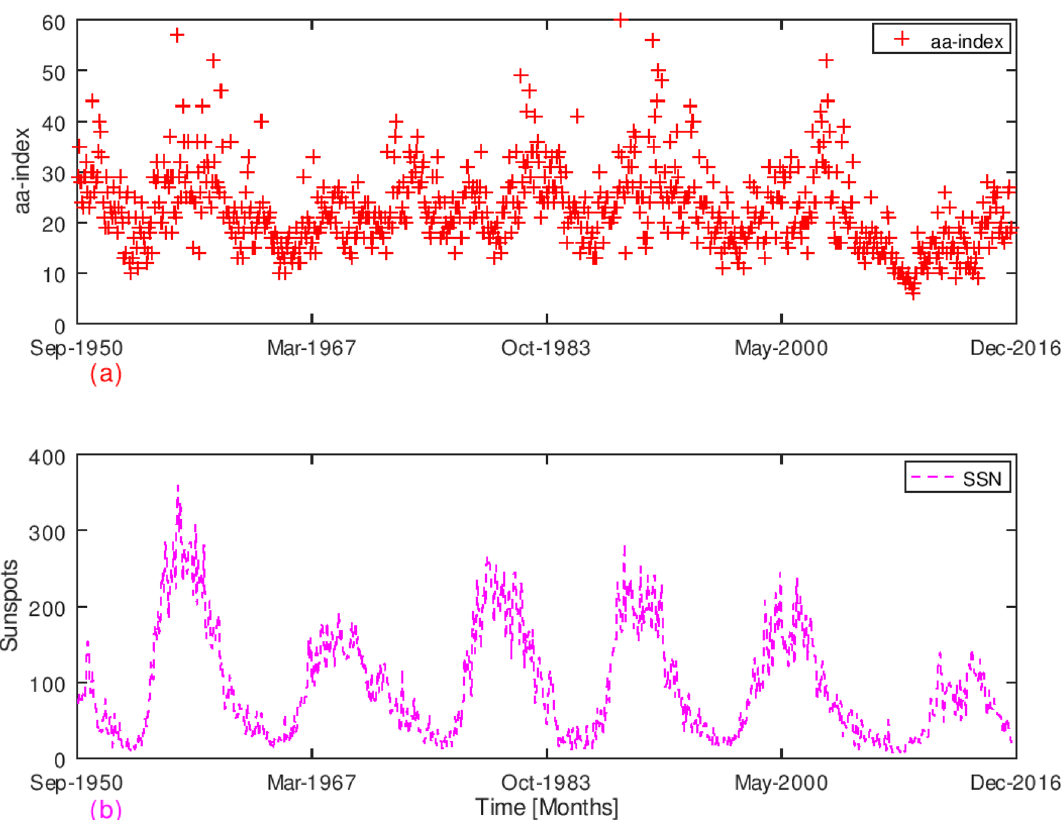
Figure 1. ( a , b ) Variations of Geomagnetic aa-index and SSN [September 1950 to December 2016]. The upper panel is the variation of geomagnetic aa-index obtained from the World Data Center of Geomagnetism, Kyoto, Japan spanning from solar cycle number 19 to solar cycle number 24. The lower panel [Magenta curve] is the variation of sunspots from solar cycle 19 to solar cycle 24. Periods of minimum solar magnetic activities correspond with periods of lowest magnitudes of geomagnetic aa-index. The Figure affirmed that sunspot variation was in-phase with geomagnetic aa-index. It was observed that solar cycle 19 was more active than preceding solar cycles, where SSN were 300 and 180 for solar cycles 19 and 20